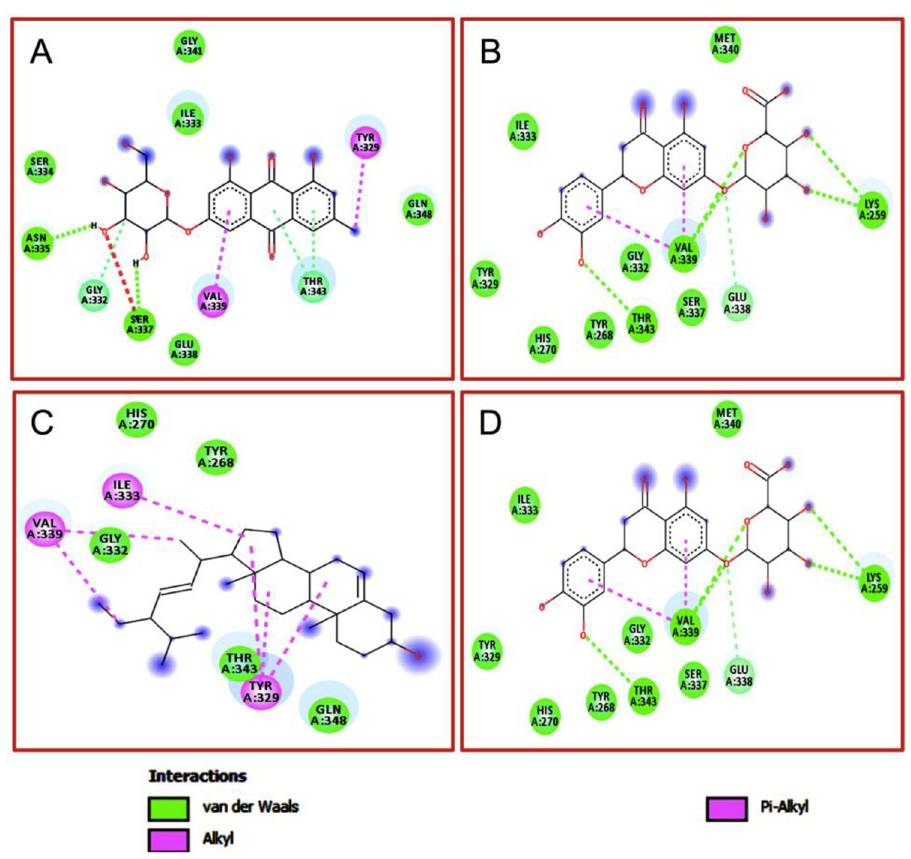
Fig 1. 2D structures of active phytoconstituents in complexation with 1R9W: where, (A) Thalirugonidine, (B) Clicoemodin, (C) Eriodictyol-7, and (D) Stigmasterol.